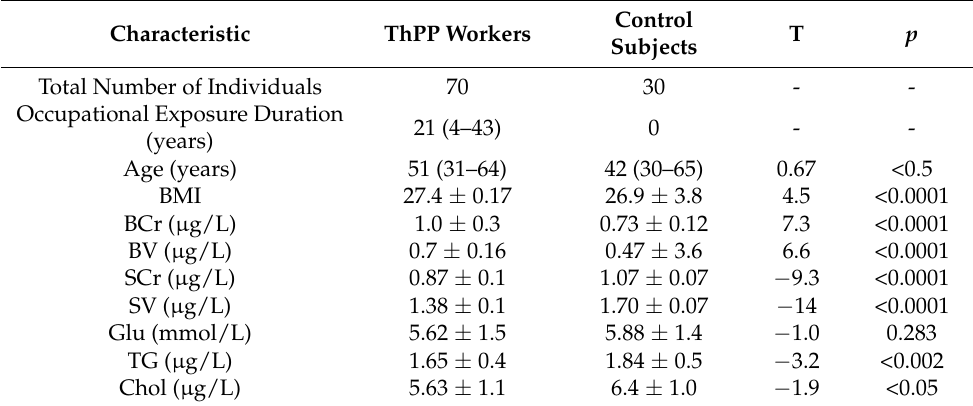
Control T p Subjects